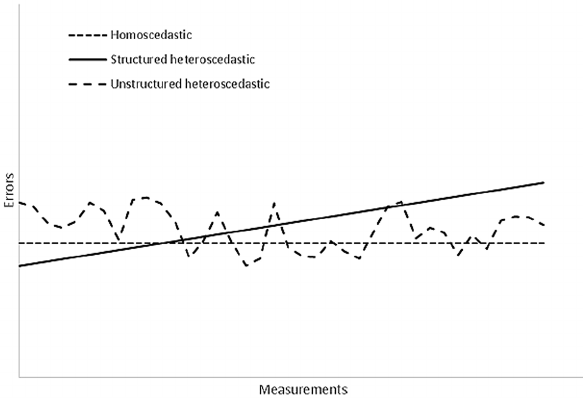
Figure 5. Distribution of errors for the cases described in Fig. 3. Homoscedastic case shows constant uncertainty and no relationship of uncertainty to the data. The structured heteroscedastic case has a linear relationship of uncertainty to the data. The unstructured het- eroscedastic case demonstrates no obvious relationship of uncer- tainty to the data and is not